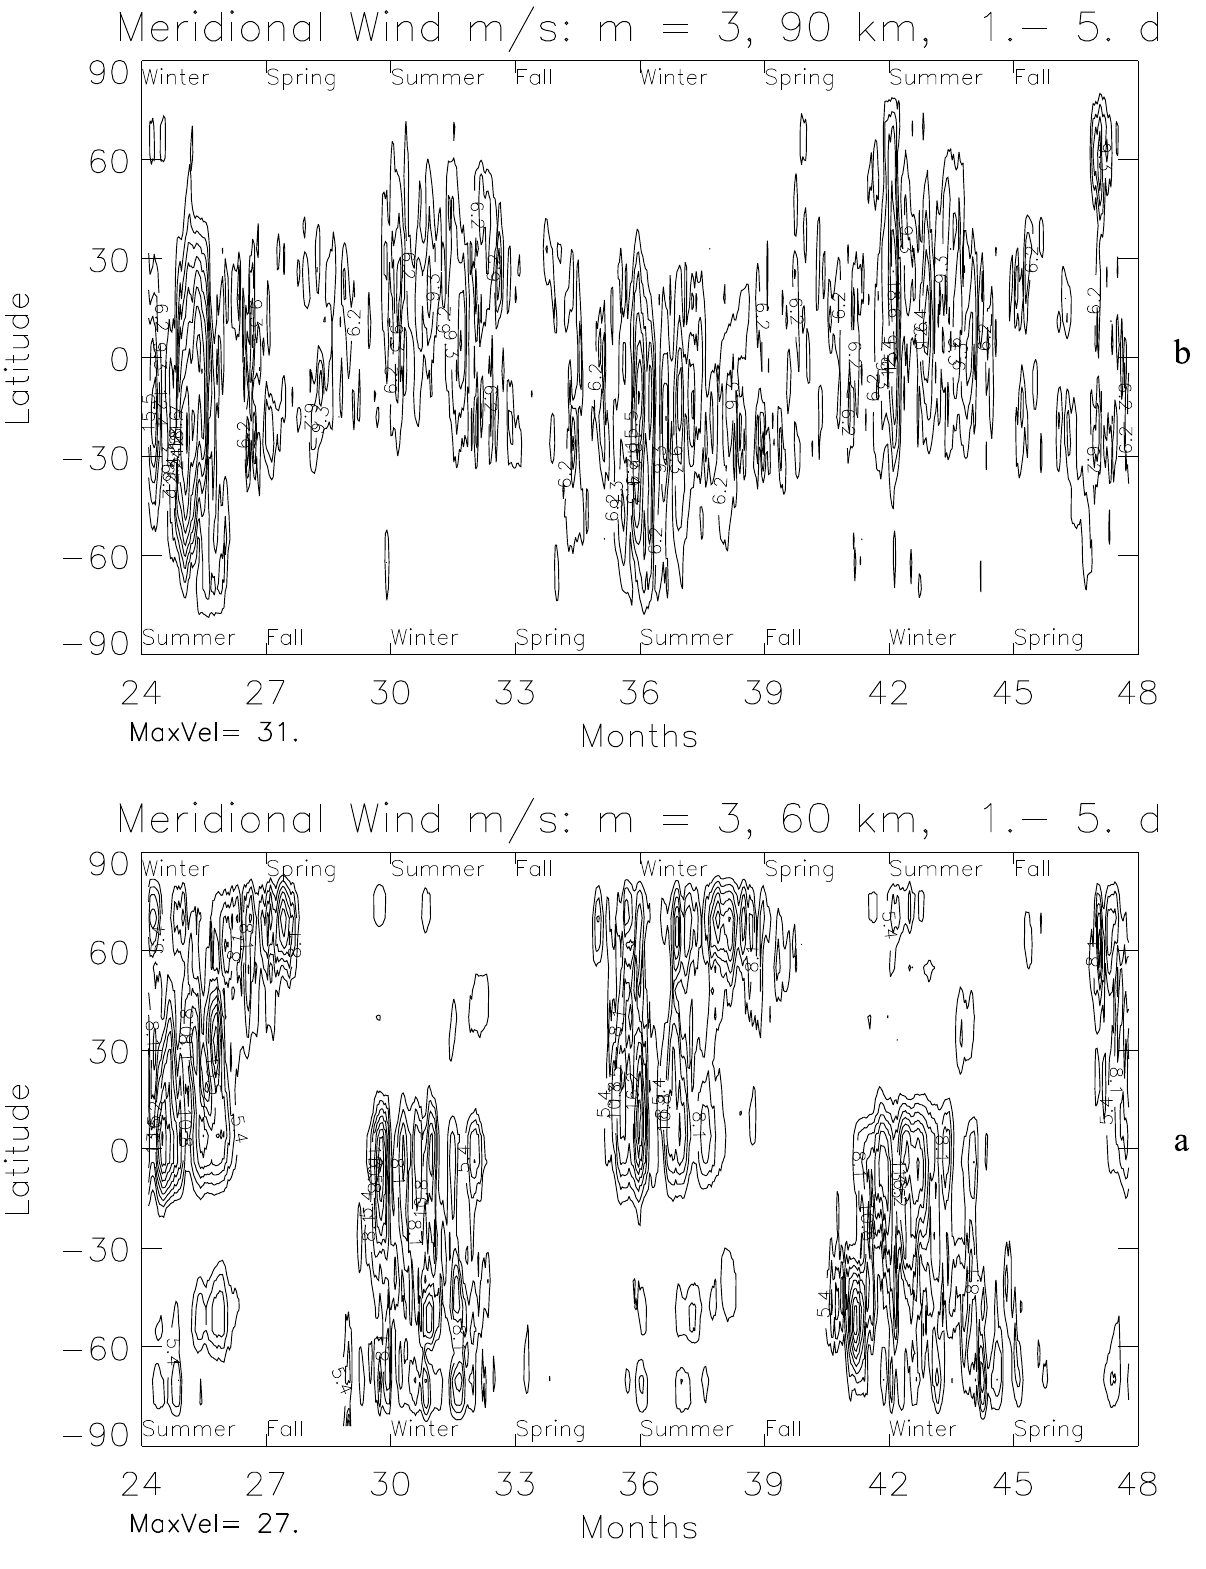
Fig. 8. Contour plot of meridional winds for PWs with m=3 at 60km ( a ) and 90km ( b ) altitudes. The chosen contour intervals are about 3 m/s, and the lowest contours are suppressed to reduce clutter. Note the systematic seasonal variations, which shows that the PWs are more prevalent at 60km (a) in the winter hemisphere but at 90km (b) in the summer